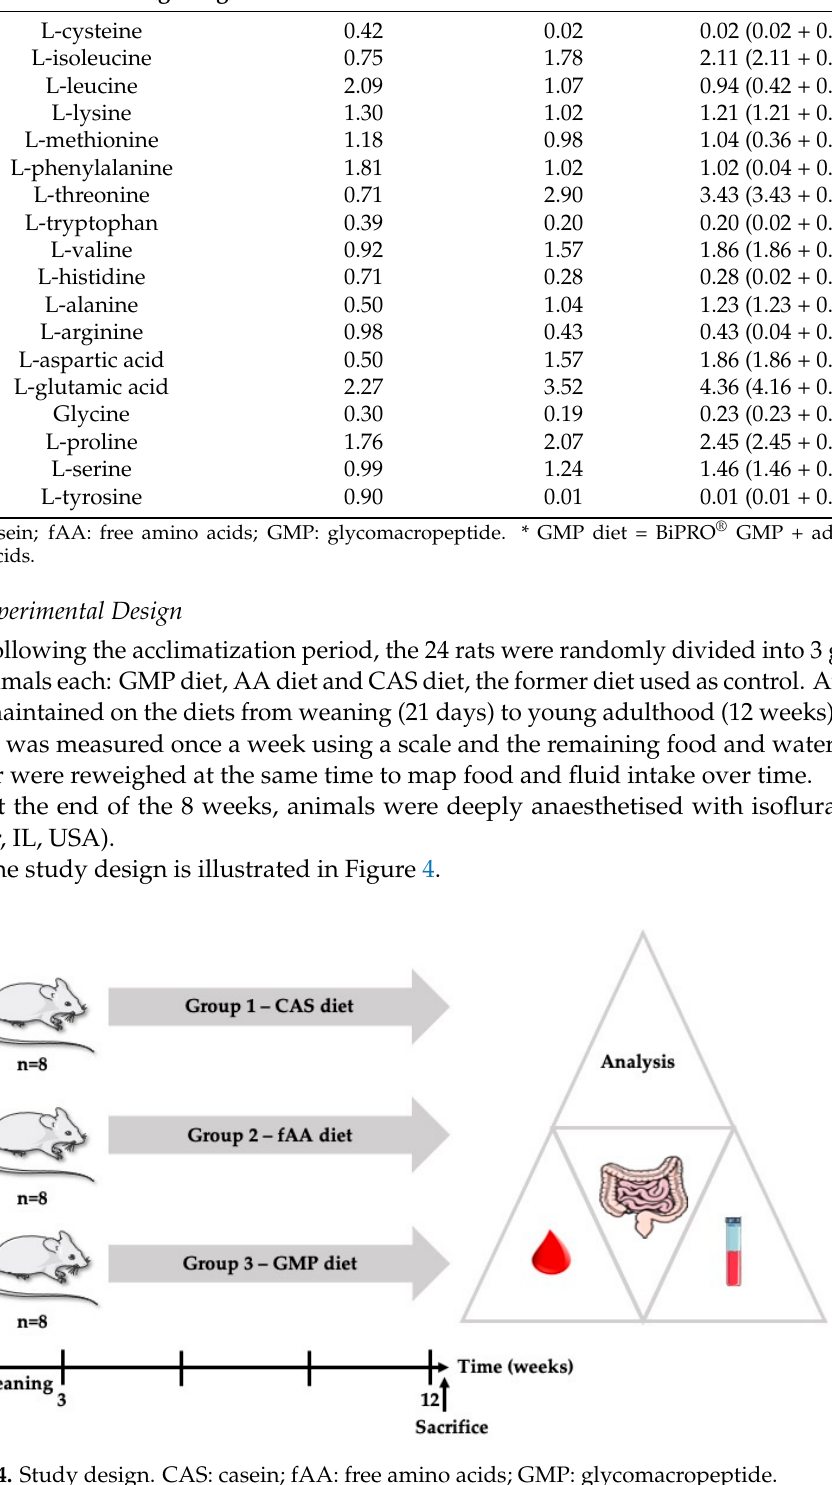
Figure 4. Study design. CAS: casein; fAA: free amino acids; GMP: glycomacropeptide.